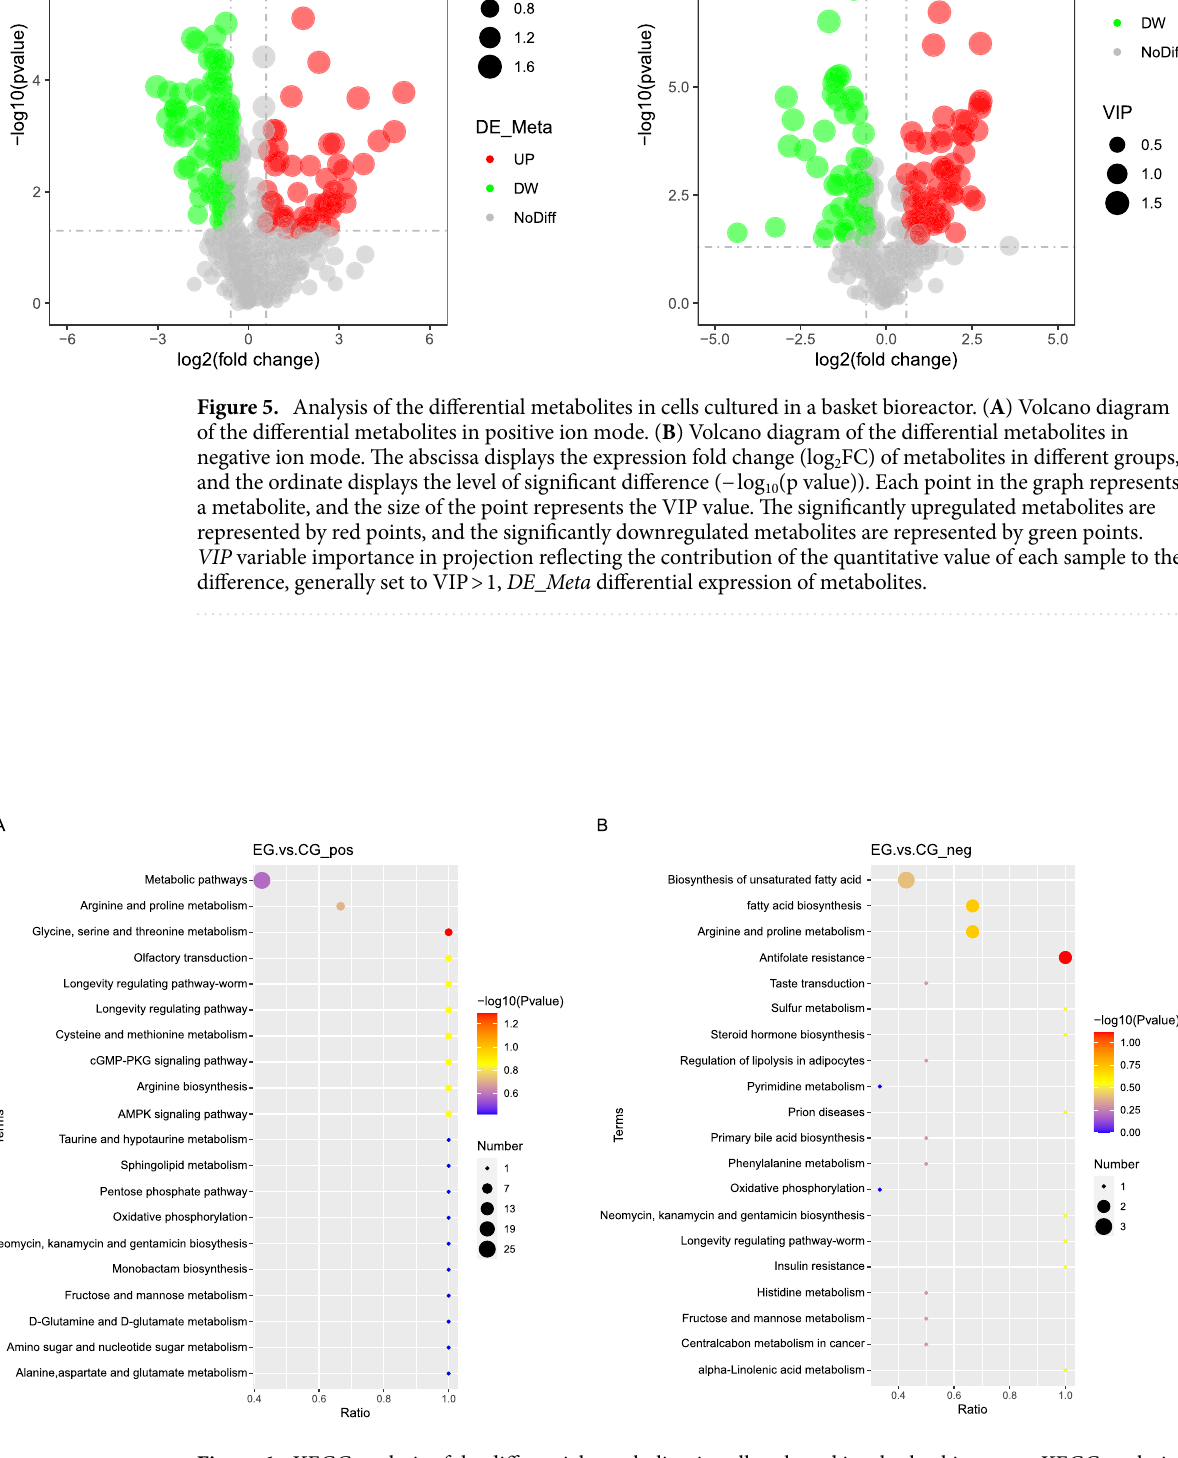
Figure 6. KEGG analysis of the differential metabolites in cells cultured in a basket bioreactor. KEGG analysis of the differential metabolites analysed in ( A ) positive ion mode and ( B ) negative ion mode 15–17